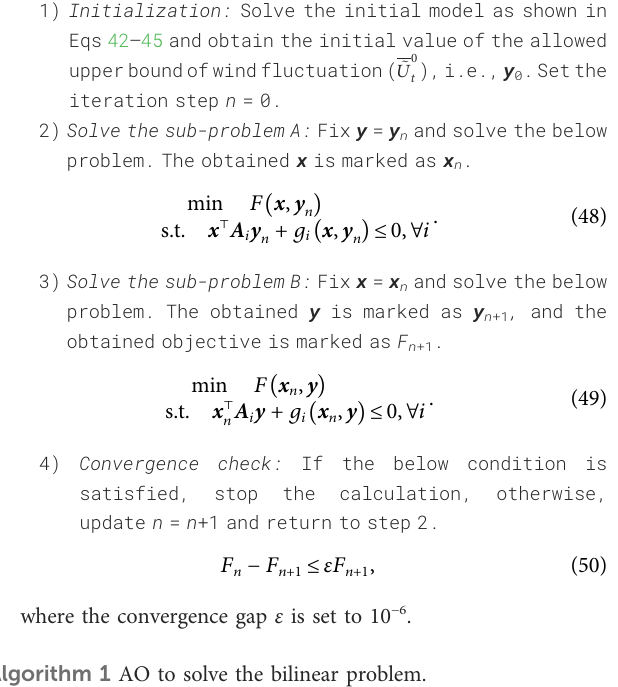
Algorithm 1 AO to solve the bilinear